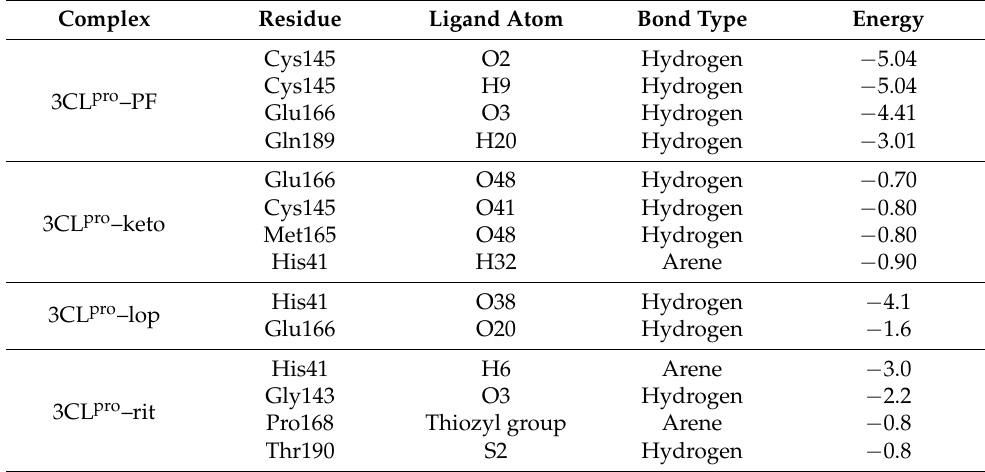
Figure 4. The minimum distance graph of protein–ligand interactions. The interaction distance between the protein and ligand in 3CLpro–PF ( A ) and 3CL pro –keto ( B ) remained constant. Interaction in 3CL pro –lop ( C ) initially remained constant but showed major fluctuations afterwards. In 3CL pro –rit ( D ), the lengths of all four bonds continuously increased. PF—PF-07321332; keto— α -ketoamide; rit—ritonavir; lop—lopinavir. Table 1. Residue and ligand atom interactions with the bond type and energy in 3CL pro